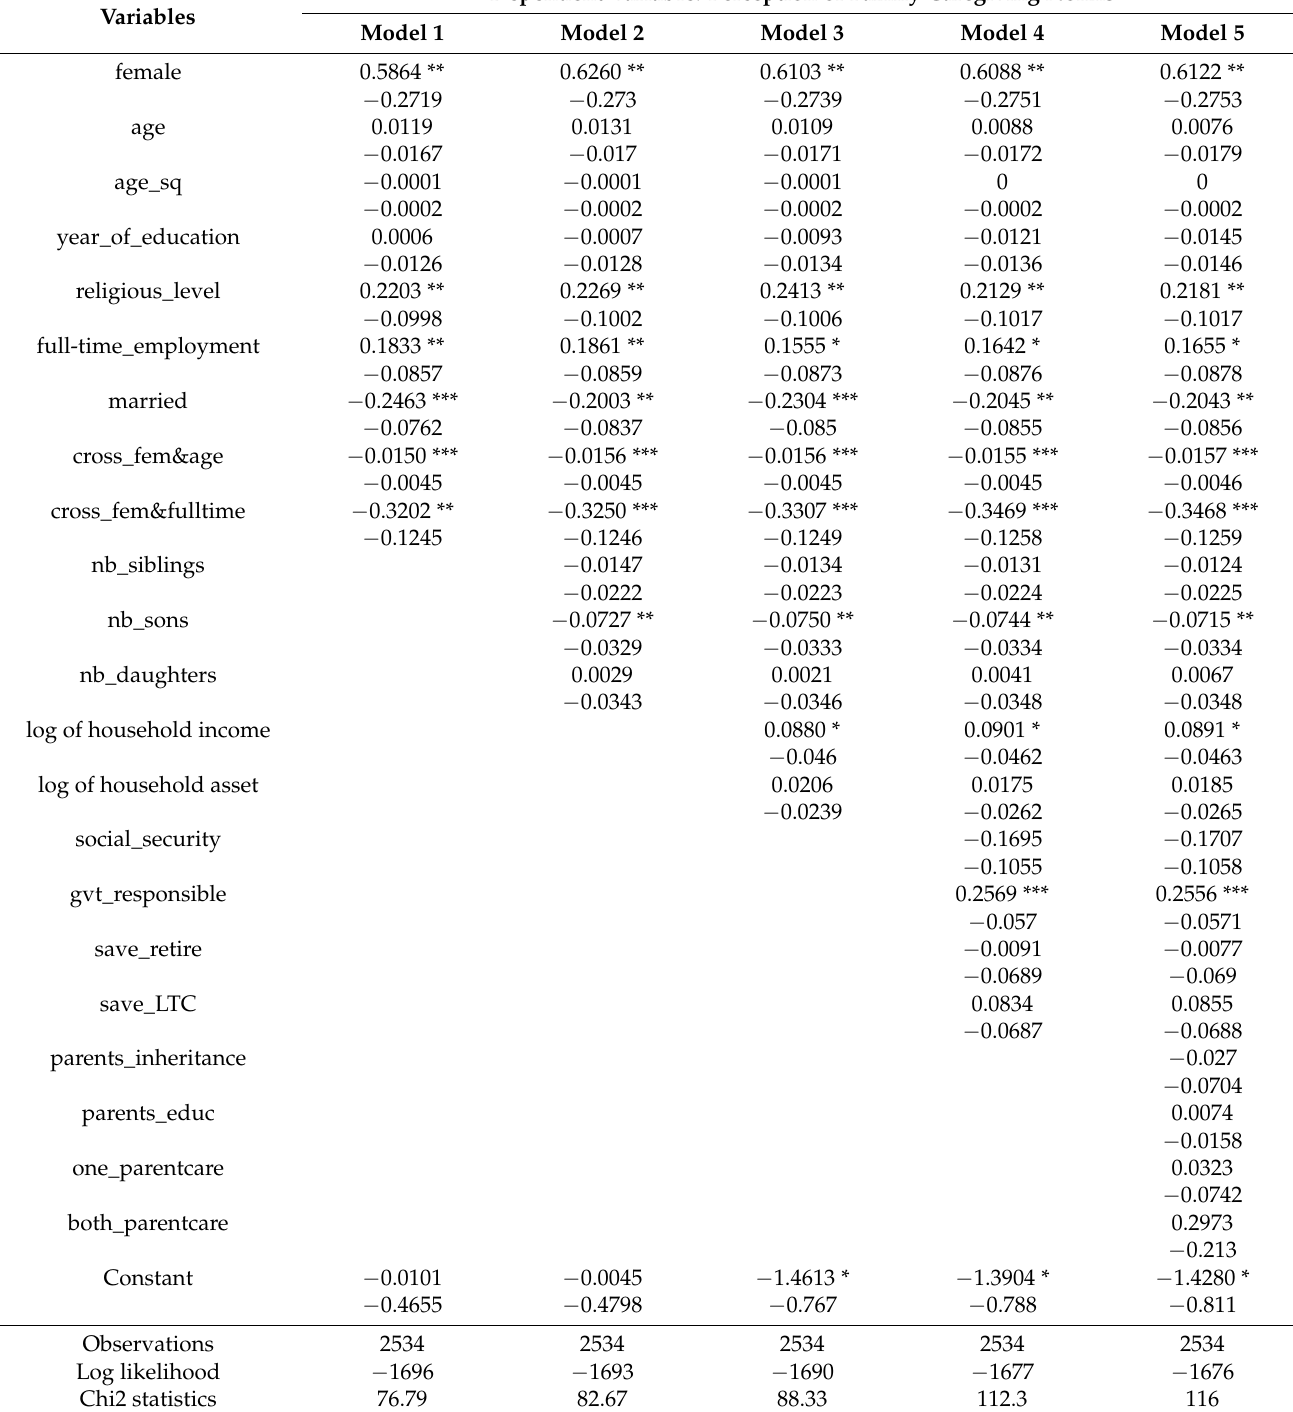
Table 5. Probit regression